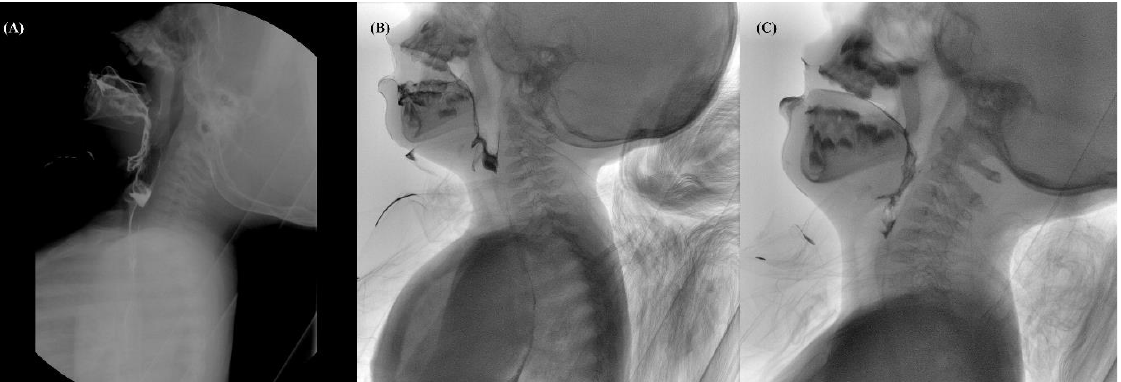
Figure 1. Video Fluoroscopic Swallowing Study (VFSS) of patient 1. ( A ) VFSS at 15 months using pureed foods (IDDSI level 4). More than half of the food remained as oral residue, and significant aspiration of pyriform sinus residue without a cough reflex (PAS 8) was observed. ( B ) VFSS at 32 months using pureed foods (IDDSI level 4). Some collections of oral residues were observed, and food penetration was shown with little contrast in the laryngeal vestibule (PAS 5). ( C ) VFSS at 5 years using pureed foods (IDDSI level 4). The lining amount of the oral residue was observed, the amount of pharyngeal residue was significantly reduced, and no penetration or aspiration was seen (PAS